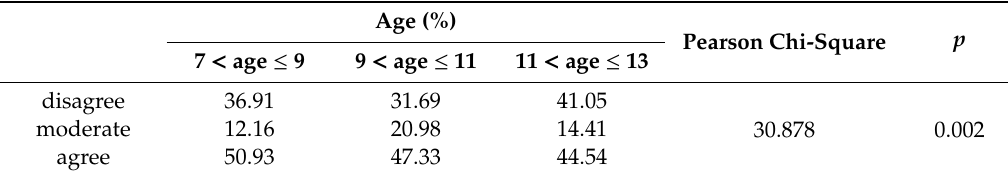
Table 3. The result of the attitudes that children using di ff erent painting materials to create di ff erent types of painting